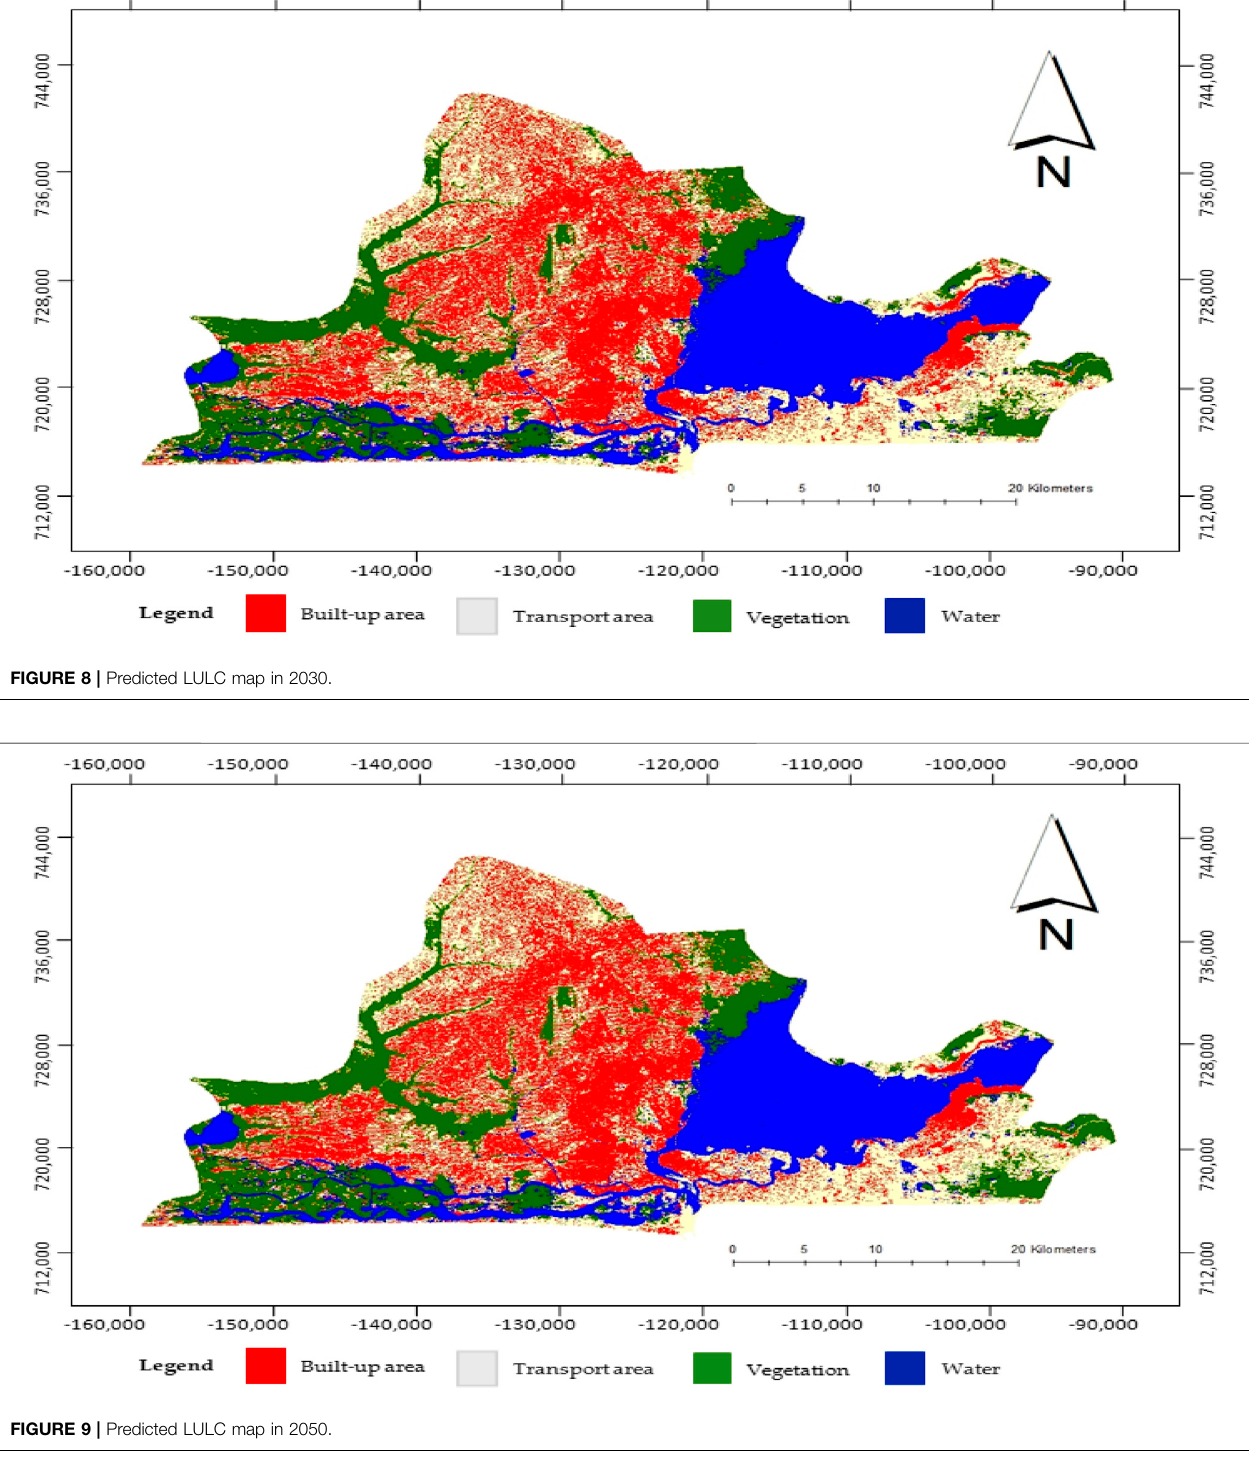
FIGURE 9 | Predicted LULC map in